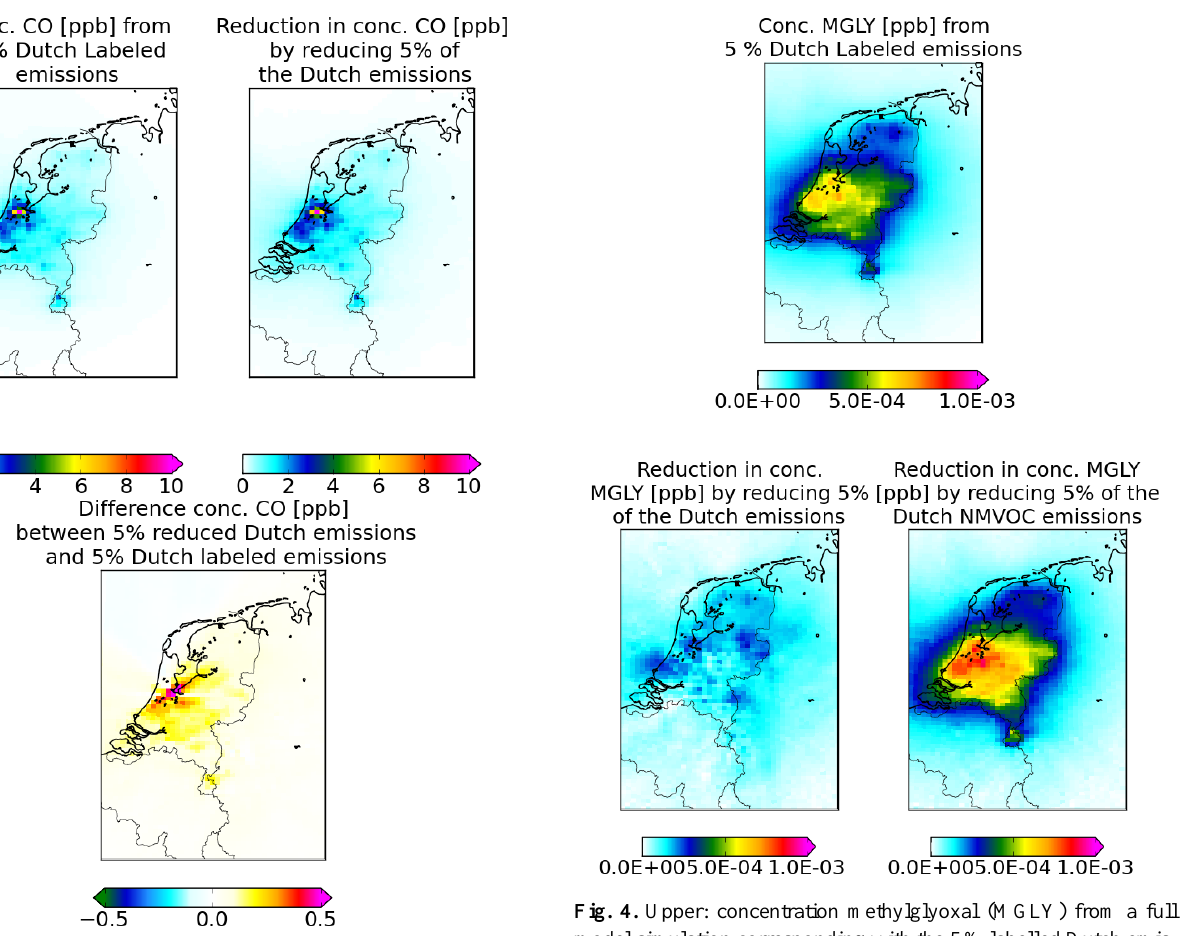
Fig. 3. Upper left: concentration carbon monoxide from a full model simulation corresponding to 5% of the Dutch emissions. Upper right: carbon monoxide concentrations from a full simulation mi- nus concentration from a simulation with 5% reduced Dutch emis- sions. Lower: the difference between those two. These simulations are valid for the month July of 2006.